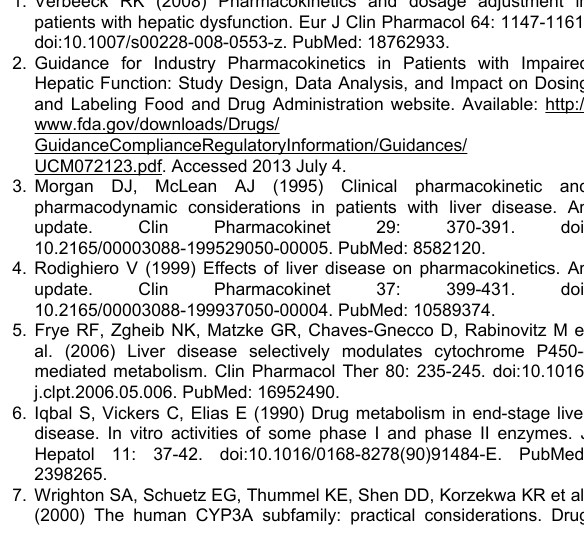
Figure S1. Correlation between correlation of expression of miRNA with CYP3A activity i.e. intrinsic clearance (X-axis) in disease (cirrhosis) group and the correlation of the expression of the same miRNA with CYP3A activity in the control (normal)